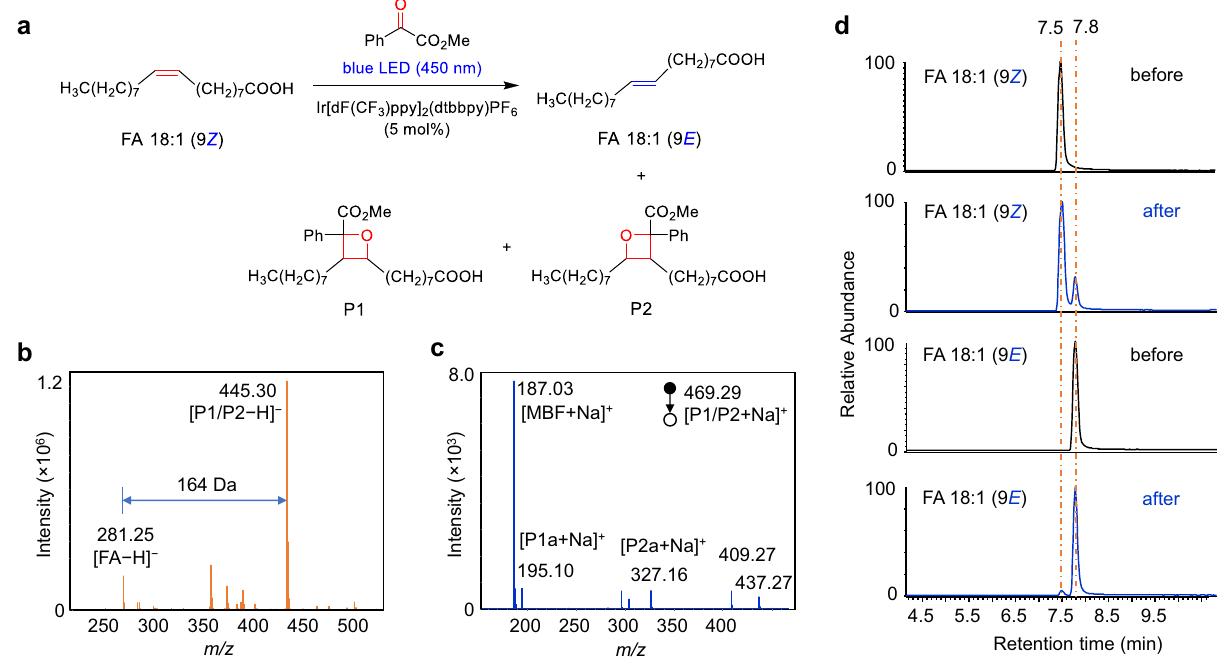
Fig. 3 Demonstration of the bifunctional reaction system for the identi fi cation of C = C bonds location and E-Z con fi guration in FA 18:1 ( Δ 9). a Photocycloaddition and photoisomerization reactions of FA 18:1 (9 Z ). The photocatalyst is Ir[dF(CF 3 )ppy] 2 (dtbbpy)PF 6 . b Mass spectrum of the photocatalytic reaction solution of FA 18:1 (9 Z ) in negative ion mode. c MS/MS spectrum of the sodiated photocycloaddition product P1/P2 in positive ion mode. Peak at m/z 187.03 denotes the fragment ion of the methyl benzoylformate motif. Peaks at m/z 409.27 and 437.27 may be assigned to the fragment ions of P1/P2 after losing the CO 2 Me and MeOH structures, respectively. d Extracted ion chromatograms (EIC) of FA 18:1 (9 Z ) and FA 18:1 (9 E ) before and after the photocatalytic reaction in negative ion